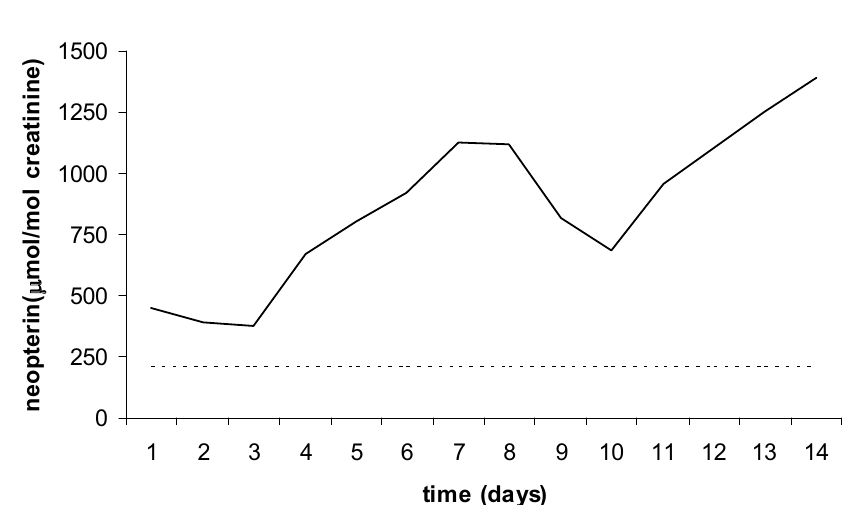
Figure 3. An 81-year-old woman with peritoneal carcinomatosis of ovarian origin that manifested as intestinal obstruction was treated with the combination of paclitaxel (90 mg/m 2 ) and carboplatin (area under the curve 2) every week. Two doses of chemotherapy were administered on days 0 and 7. The administration of therapy was complicated by diarrhea (more than 10 bowel movements/days) that started on day 5. The diarrhea was first con- sidered to be the result of re-establishment of bowel transit after previous obstruction, and second dose of thera- py was administered, but the diarrhea continued and was accompanied by a rise of urinary neopterin. Despite sup- portive therapy, the general status of the patient did not improve, and she died less than 24 hours after the last measurement. A gradual rise in urinary neopterin concentrations was observed until the death of the patient. Serum CA125 decreased during the observation from 1158 to 800 U/ml. The upper limit of normal urinary neopterin concentrations is indicated by dashed